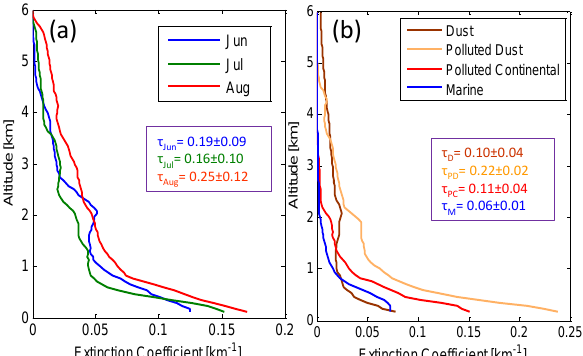
Figure 8. Vertical distribution of mean aerosol extinction coefficient for (a) June, July and August, and (b) different dominant aerosols during summer 2010. The calculated aerosol optical depths for re- spective extinction profiles are given in respective colors. The stan- dard deviations of respective means are provided in supplementary materials (Fig. S4 in the